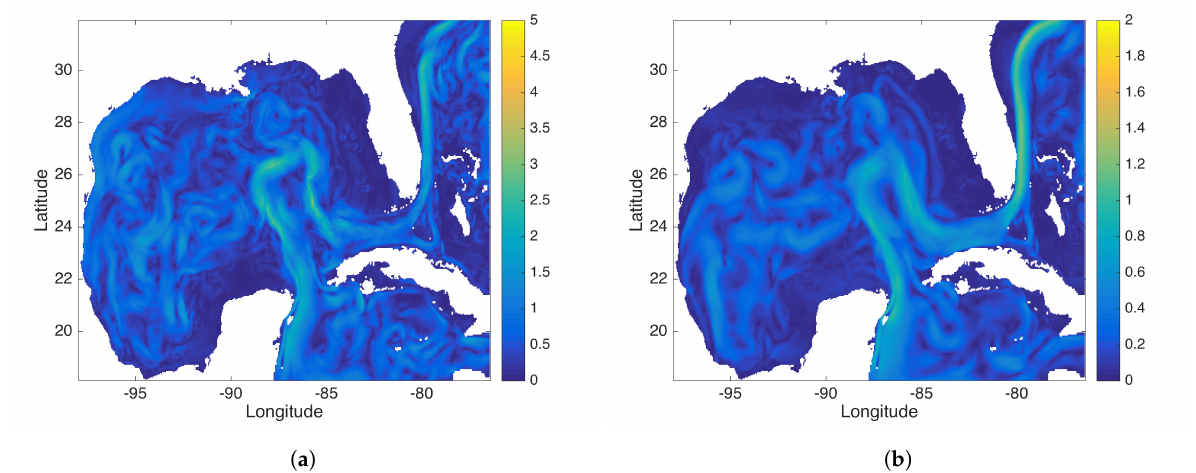
Figure 12. This figure compares the ( a ) DMD and ( b ) rDMD background mode identified by data from the Gulf of Mexico (GOM). This background mode captures the ocean current passing through the GOM.